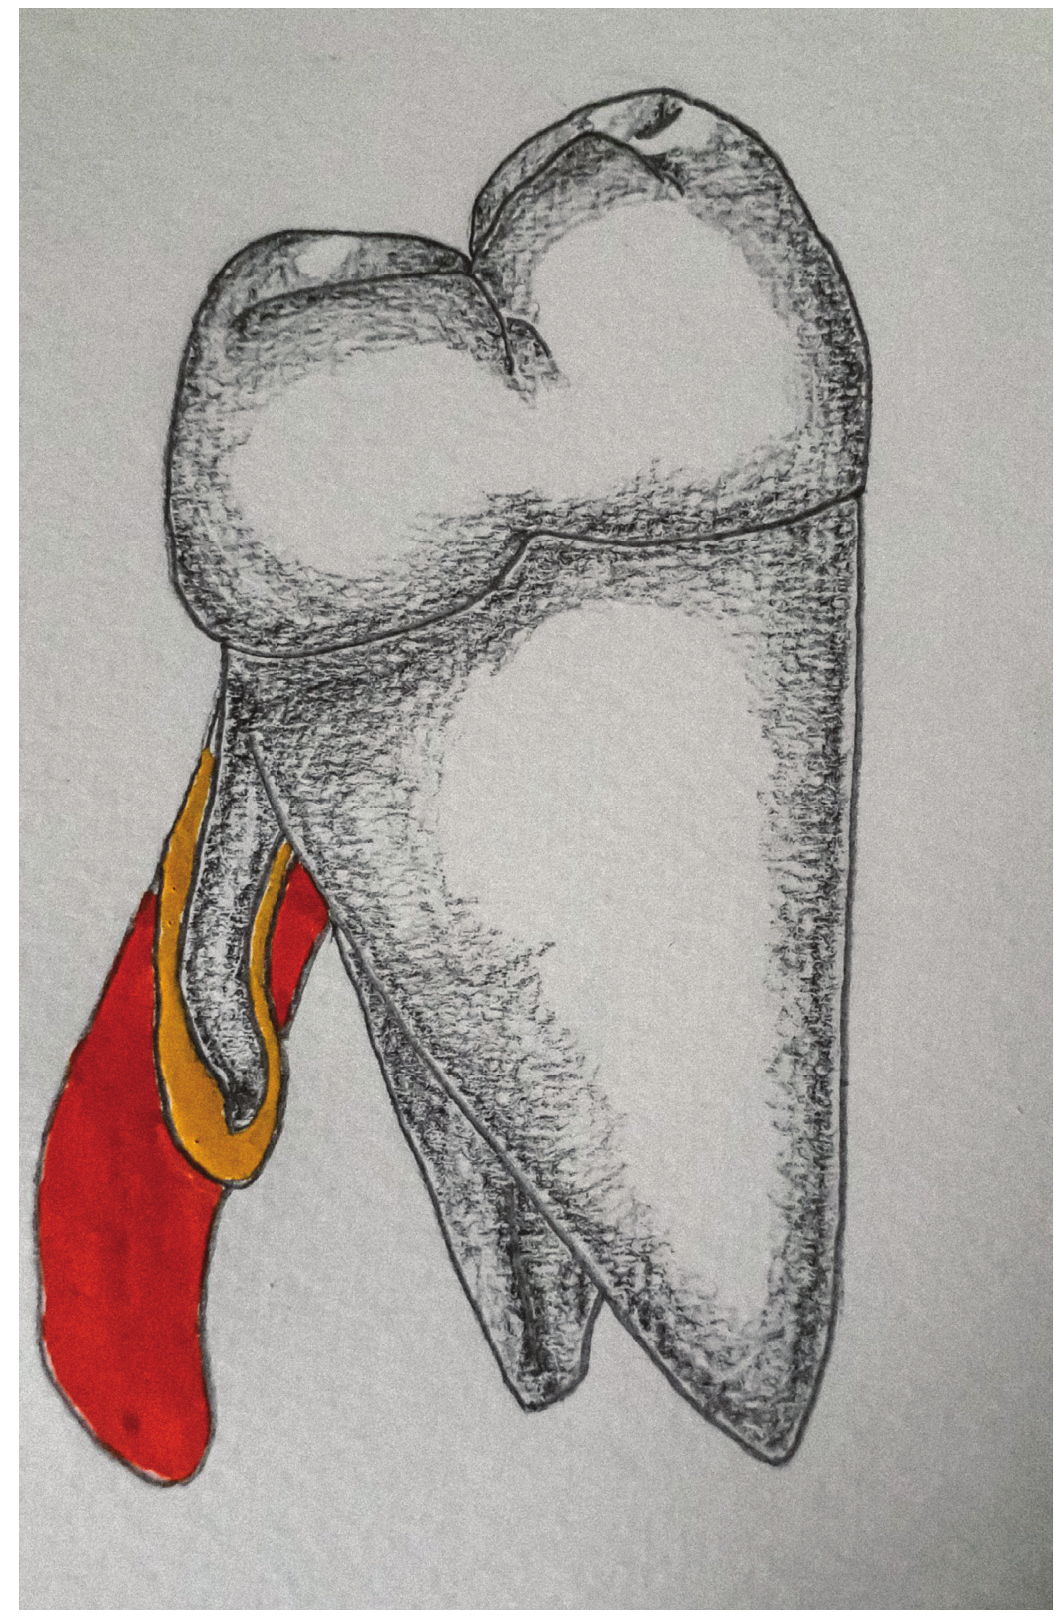
Figure 3: Distal proximal view of right three-rooted PMFM showing variations in the size of the distolingual